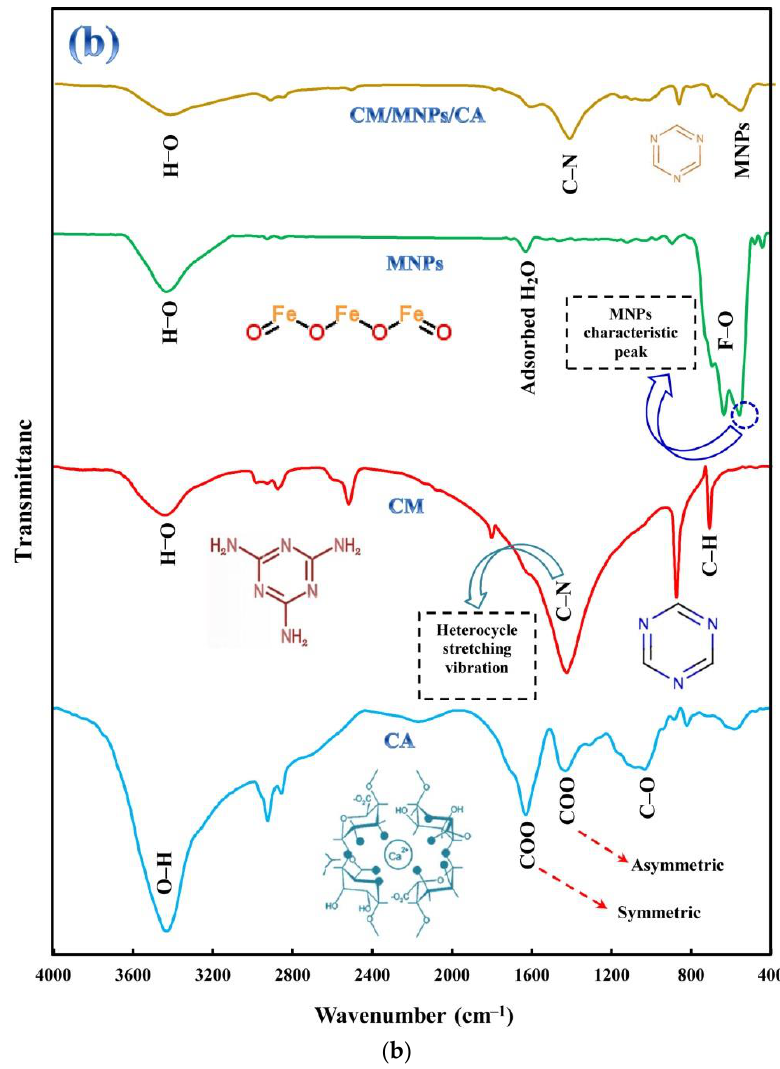
Figure 2. XRD patterns of CA, CM, MNPs and their encapsulated form ( a ), along with FT-IR spectra of CA, CM, MNPs and CM/MNPs/CA microcapsule ( b ). FTIR analysis was performed on powdered samples using the KBr pellet method.